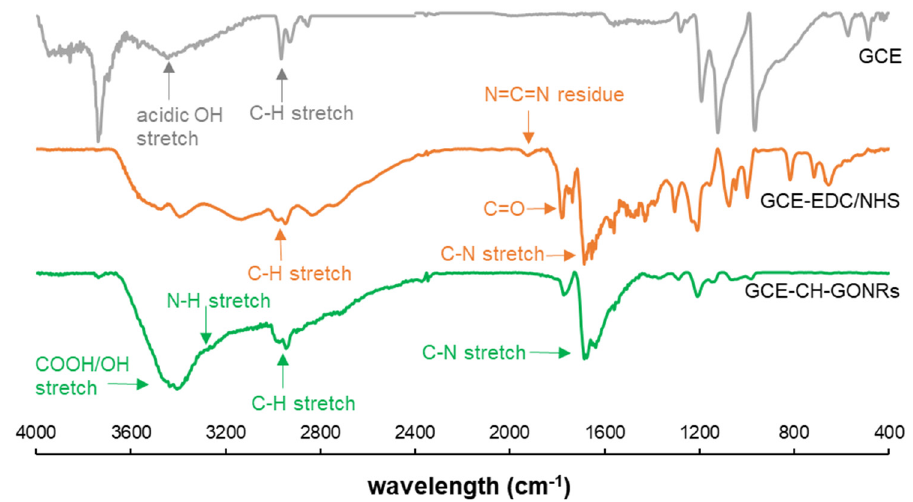
Figure 2. The FTIR spectra of GCE (grey), GCE post 1-ethyl-3-(3-dimethylaminopropyl) carbodiimide hydrochloride (EDC)/NHS activation (orange) and GCE-EDC/NHS-CH-GONR (green).